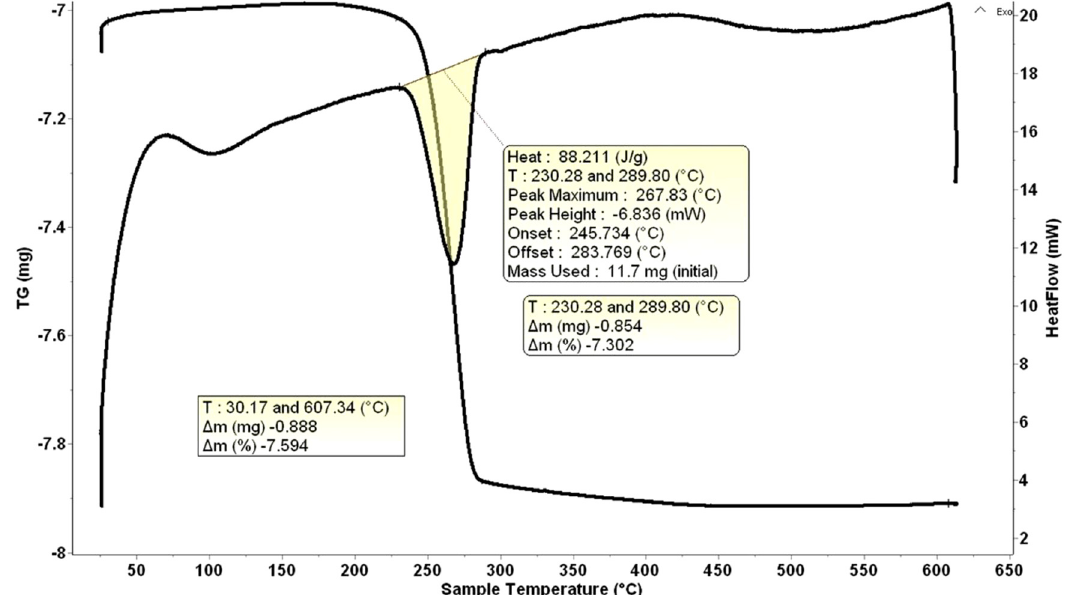
Fig. 10. DSC-TG curve showing decomposition of Zinc Carbonate Hydroxide Hydrate with formation of ZnO on porous carbon